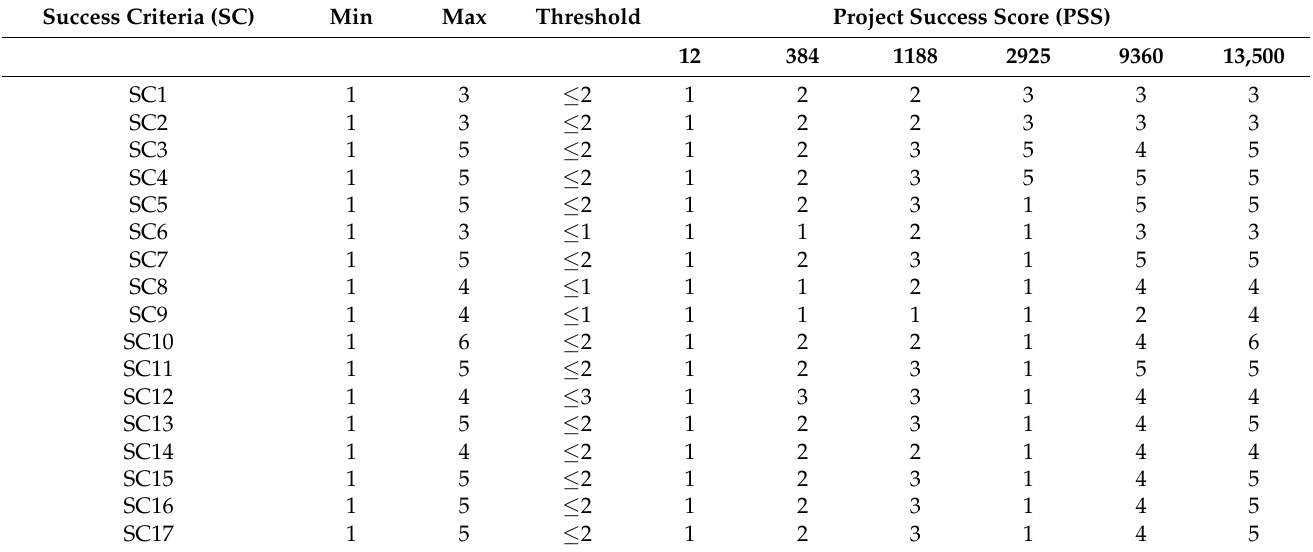
Table 2. Min, max, and threshold performance values of SC and